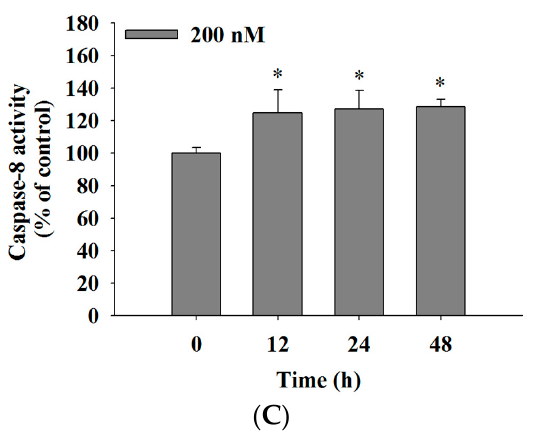
Figure 5. Bufalin affects the activities of caspase-3, -9, and -8 in U-2 OS cells. U-2 OS cells (1 × 10 5 cells/well) were incubated with 200 nM of bufalin for 0, 12, 24, and 48 h; then the cells were harvested and re-suspended in 25 μ L of 10 μ M substrate solution containing ( A ) PhiPhiLux-G1D1 for caspase-3, ( B ) CaspaLux9-M1D2 for caspase-9, and ( C ) CaspaLux8-L 1 D 2 for caspase-8 activity measurements, as described in Materials and Methods. The results are shown as a mean ± SD ( n = 3); * p < 0.05, significant difference between bufalin-treated groups and the control as analyzed by Student’s t test.